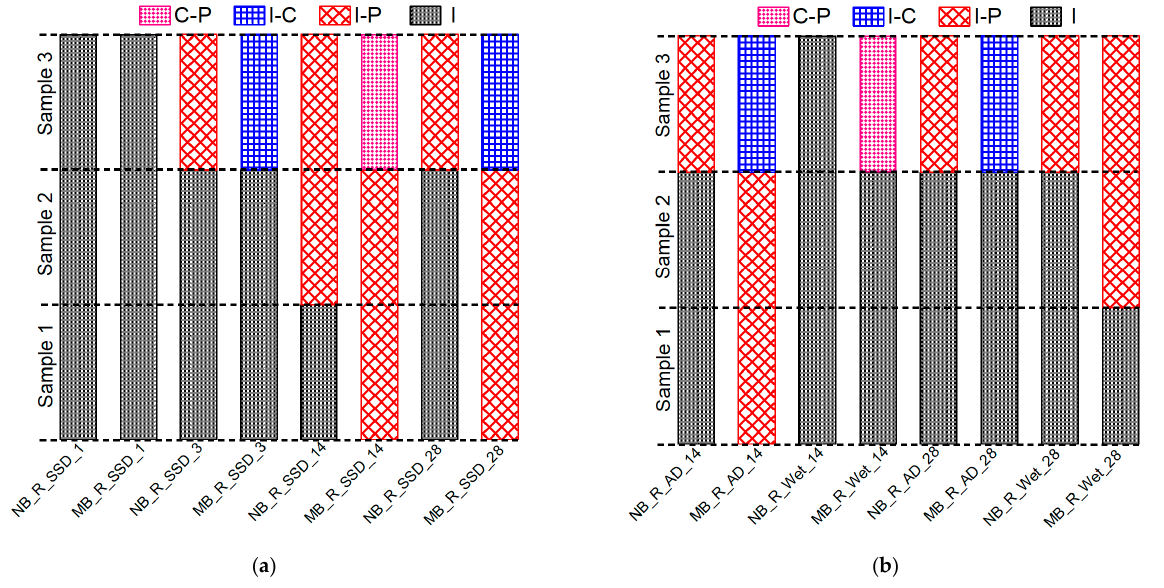
Figure 15. Fracture modes of all the composite specimens of Series II and Series III. ( a ) Specimens tested at early ages. ( b ) Different moisture content at the